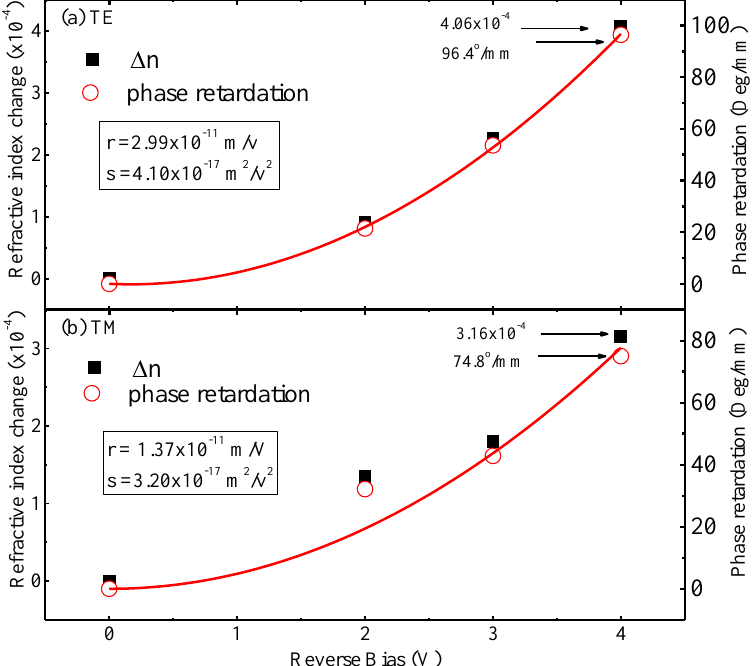
Figure 7. Phase retardation ( ∆ φ ) and refractive index change ( ∆ n) as a function of reverse bias voltages for ( a ) TE and ( b ) TM polarization. The curve is a fit to the ∆ φ data to extract EO linear coefficient ( r ) and quadratic coefficient ( s ).